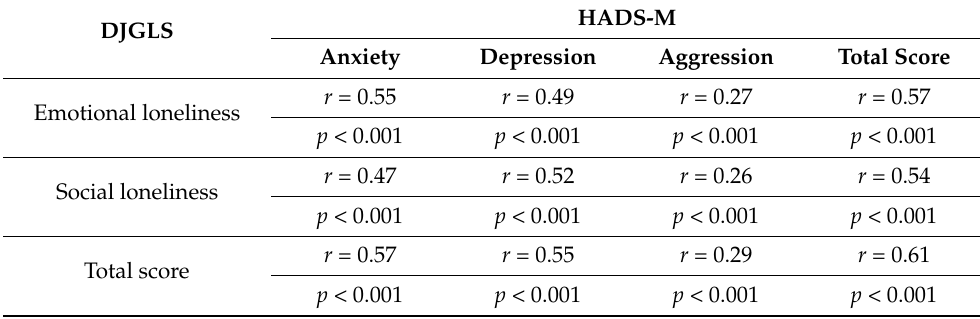
Table 7. Correlations between sense of loneliness and anxiety, depression and aggression. DJGLS